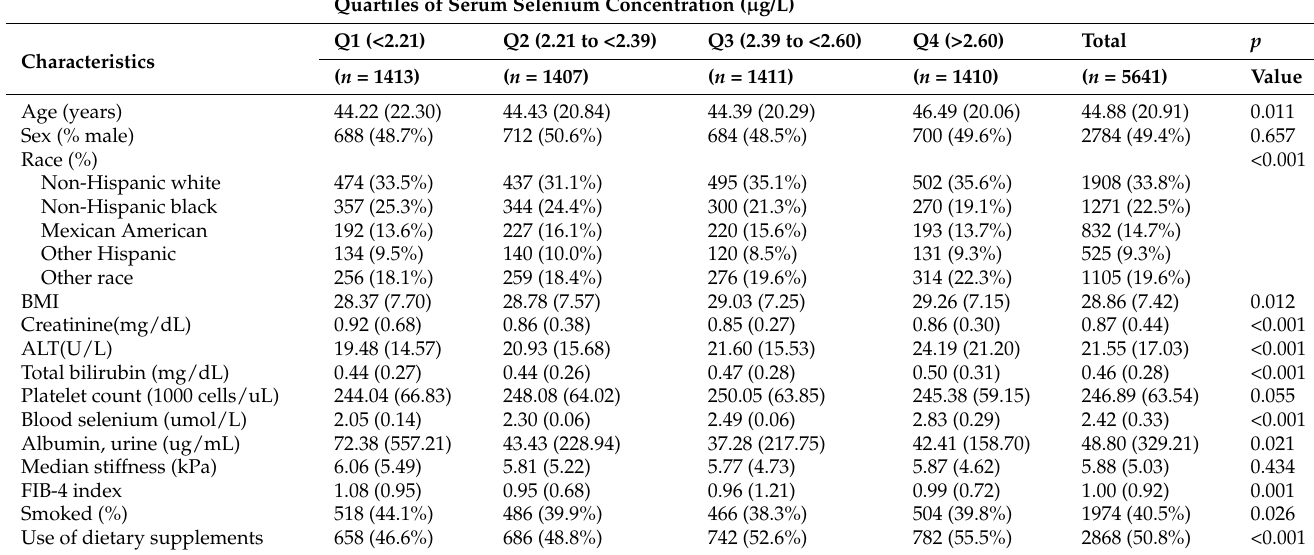
Table 4. Characteristics of study participants by quartile of serum selenium concentration (Quartiles 1–4).